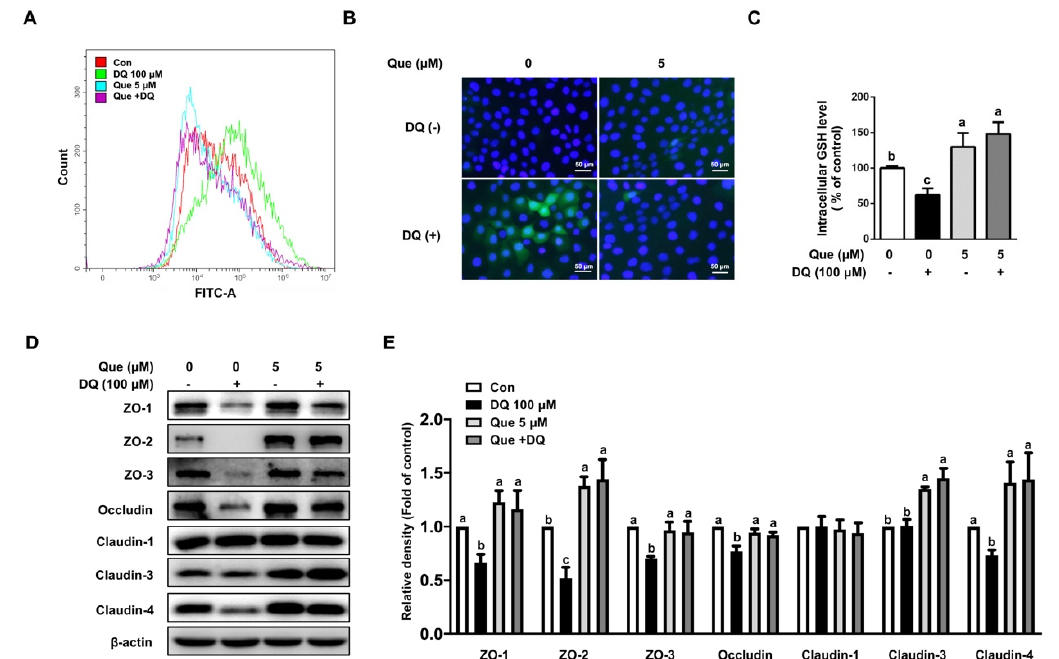
Figure 3. Quercetin attenuated diquat-induced ROS accumulation and reduced protein abundance of tight junction proteins in IPEC-1 cells. IPEC-1 cells were treated as described in Figure 2. ( A ) DCFH-DA-positive populations were detected by flow cytometry analysis. ( B ) Intracellular ROS levels were determined by fluorescence microscope (magnification × 200). ( C ) Intracellular GSH levels were measured. ( D , E ) Protein abundance for ZO-1, ZO-2, ZO-3, occludin, claudin-1, claudin-3, and claudin-4 were determined and analyzed by the Western blot assay. β -actin was used as the loading control. Representative experimental results were repeated in three independent experiments and values are means ± SEMs, n = 3. Means without a common letter are considered as a significant difference, p < 0.05.